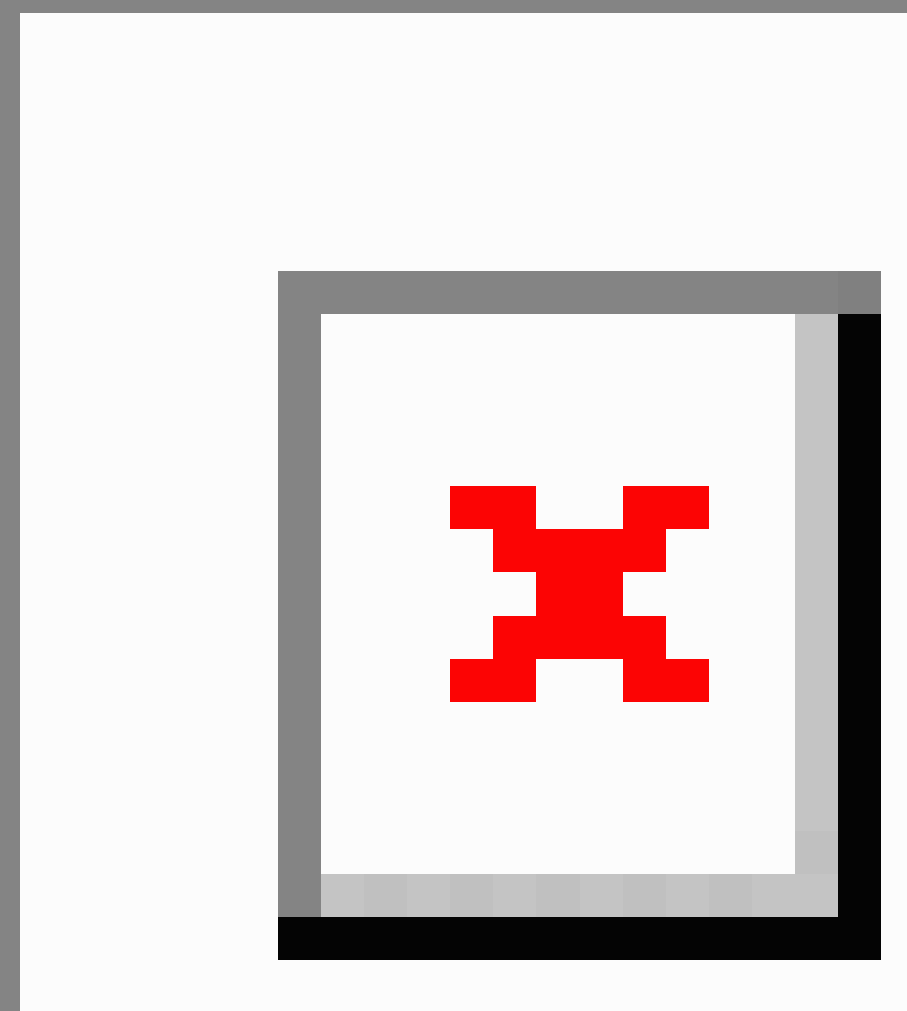
Figure 2. Screenshot of the Happy@Work